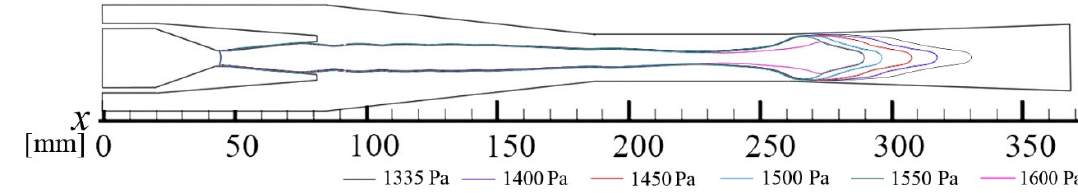
Figure 7. Sonic lines with different P d .